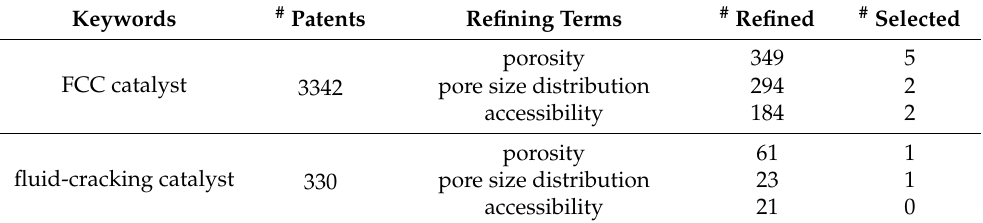
Table 5. Patent search results in the EPO